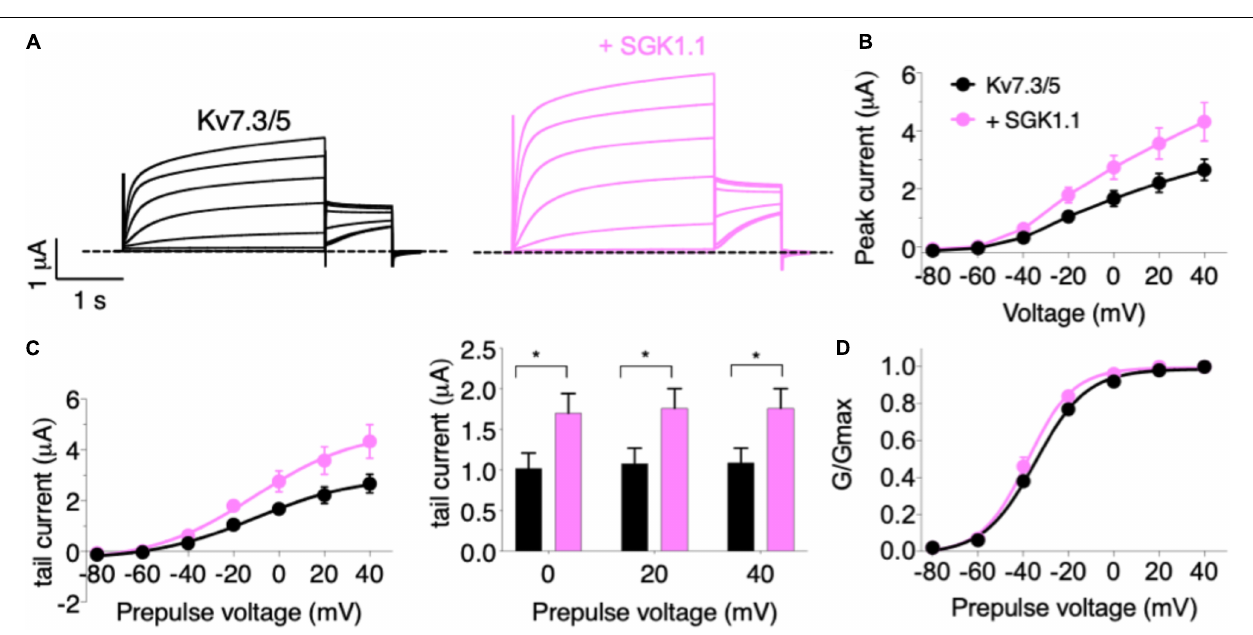
FIGURE 2 | SGK1.1 increases heteromeric Kv7.3/5 currents like heteromeric Kv7.2/3, supporting the need for heteromeric channel assembly to observe SGK1.1 effects. (A) Currents elicited in Xenopus oocytes after coinjection of cRNAs from Kv7.3/5 channel alone (first panel) or in combination with wild-type SGK1.1 (second panel). (B) Peak current/voltage relationship. (C) Tail current (left) and tail currents measured at –30 mV after 0, + 20 or + 40 mV depolarizing pulses. Values represent mean ± SEM (Multiple t -test Holm-Sidak correction method; * p < 0.05). (D) Normalized conductance. Legends are indicated on (B)